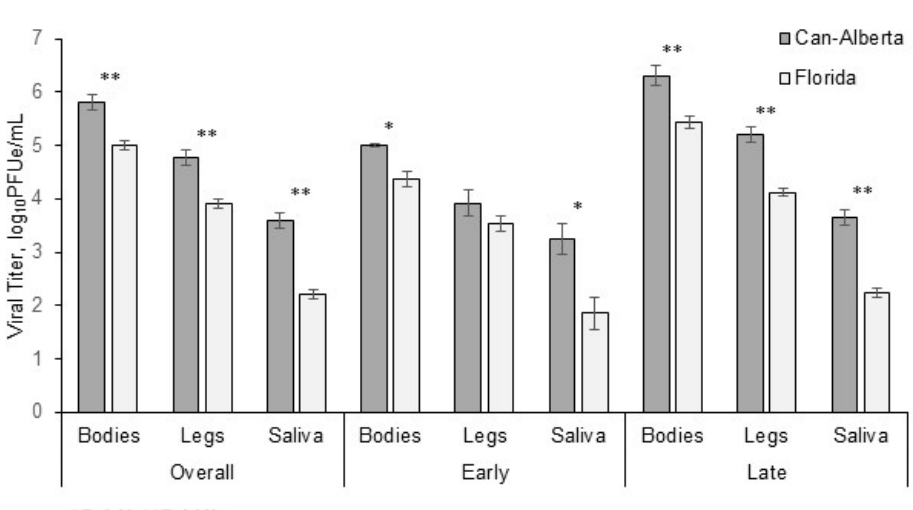
Figure 1. Viral titers in the bodies, legs, and saliva of Culicoides sonorensis infected with Can-Alberta or Florida strain of EHDV-2. Overall viral titers, viral titers during the first 3–7 days post-feeding (early), and viral titers during the last 8–13 days post-feeding (late) are shown for both strains. Error bars indicate the standard error of the mean.